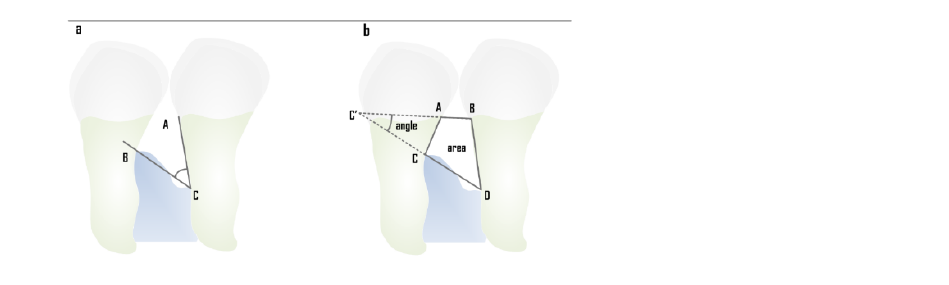
Figure 1. ( a ) Conventional defect angle measurement between ACB (BDA), ( b ) Modified measure- ment of the defect angle AC’C (Alveolar crest angle—ACA), and defect area within ABDC (Alveolar space area—ASA).